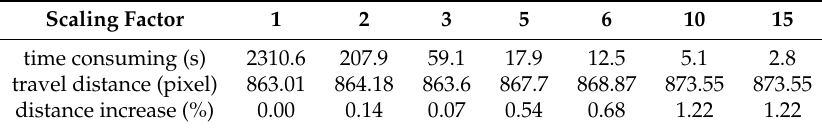
Table 2. Map scaling-based path planning performance